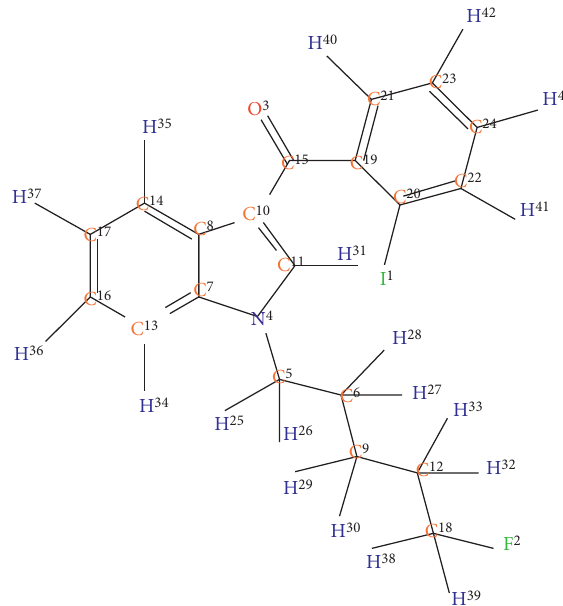
Figure 5: The structure of the molecule 9889172. Table 1: The cod identification (CID), molecular formula (MF), molar weight filter (MW), types, and the numbers of atoms, rings, and aromatic rings in the molecules.